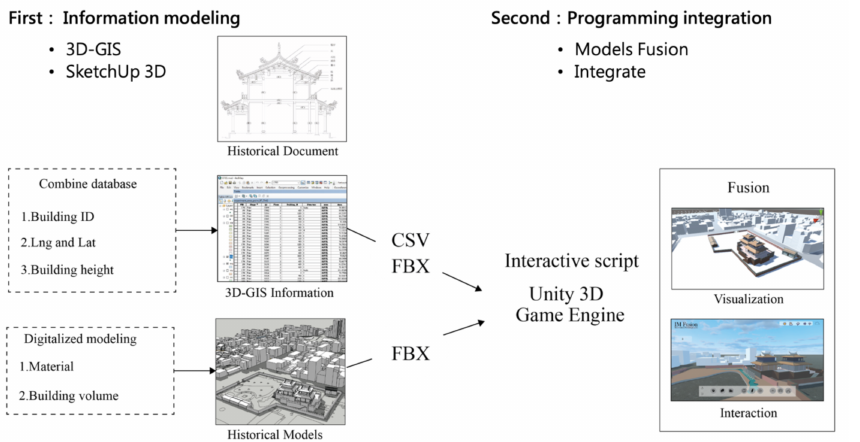
Figure 4. Two stages of procedural modeling.